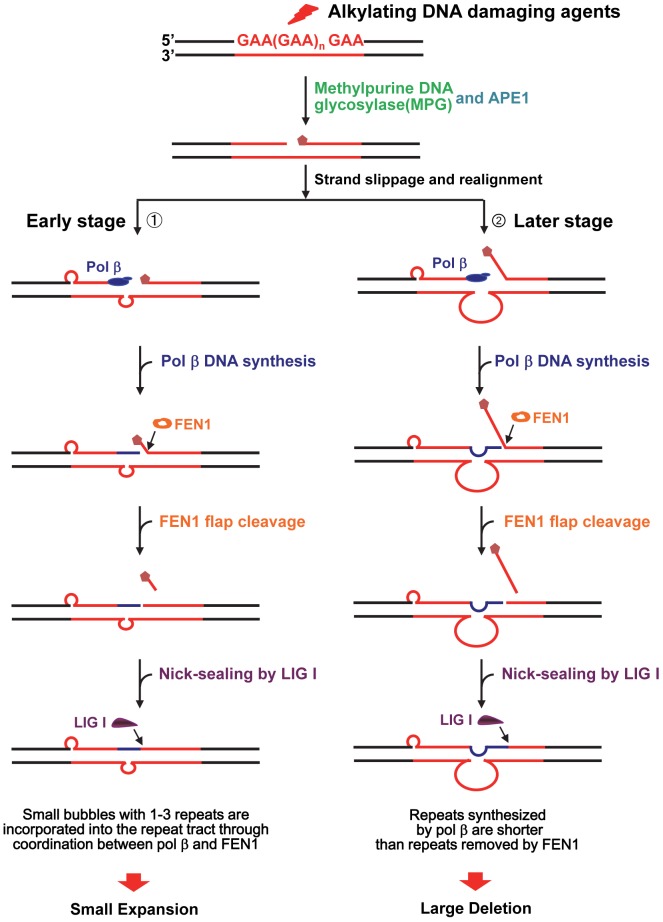
A model for large GAA repeat contractions/deletions and small expansions induced by alkylating DNA base lesions via BER.Alkylating DNA damaging agents such as temozolomide can result in methylation of a guanine and/or an adenine. Methylated bases can be removed by N-methylpurine DNA glycosylase (MPG). Subsequently, this leaves an abasic site that is 5'-incised by APE1 generating a ssDNA break in a GAA repeat tract. This initially causes dissociation of the upstream damaged strand and DNA slippage allowing the formation of a small upstream GAA repeat loop (Sub-pathway 1). This further results in the formation of a small template loop and a short GAA repeat flap at the downstream of the strand break. Pol β performs limited DNA synthesis, and FEN1 cleaves a short GAA repeat flap, thereby causing small repeat expansion (Sub-pathway 1). At a later stage of BER, the small template loop expands into a large loop allowing the dissociation of the downstream strand that subsequently leads to the formation of a long downstream GAA repeat flap. Pol β synthesizes a limited number of repeats to bypass the template loop. FEN1 then cleaves the long flap, resulting in a large GAA repeat contraction/deletion (Sub-pathway 2).